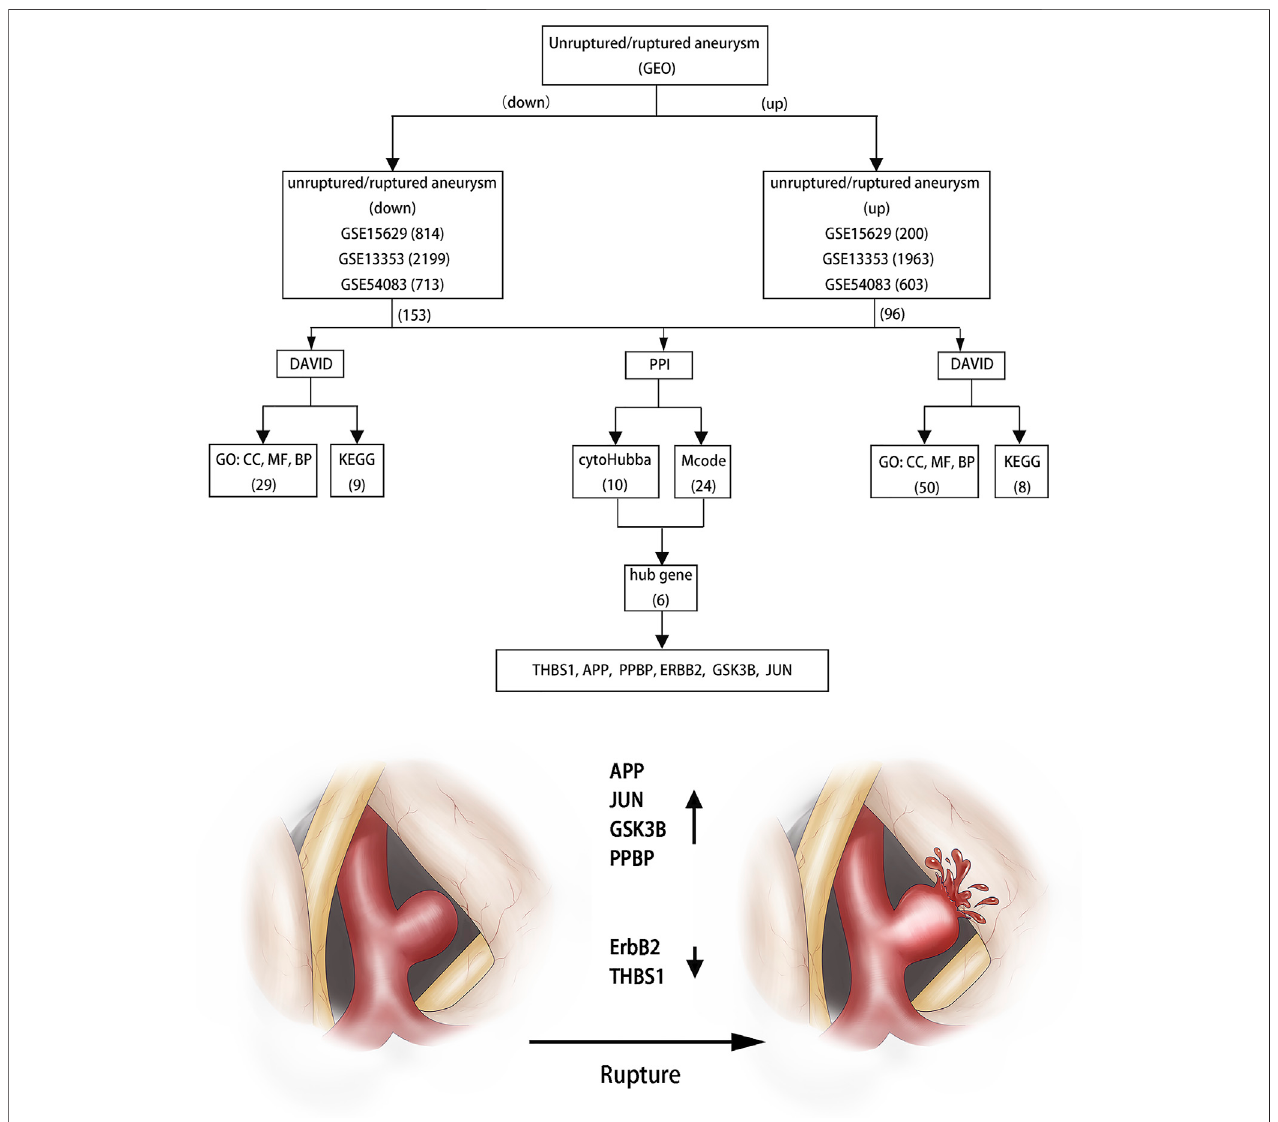
FIGURE 7 | Flowchart of bioinformatics